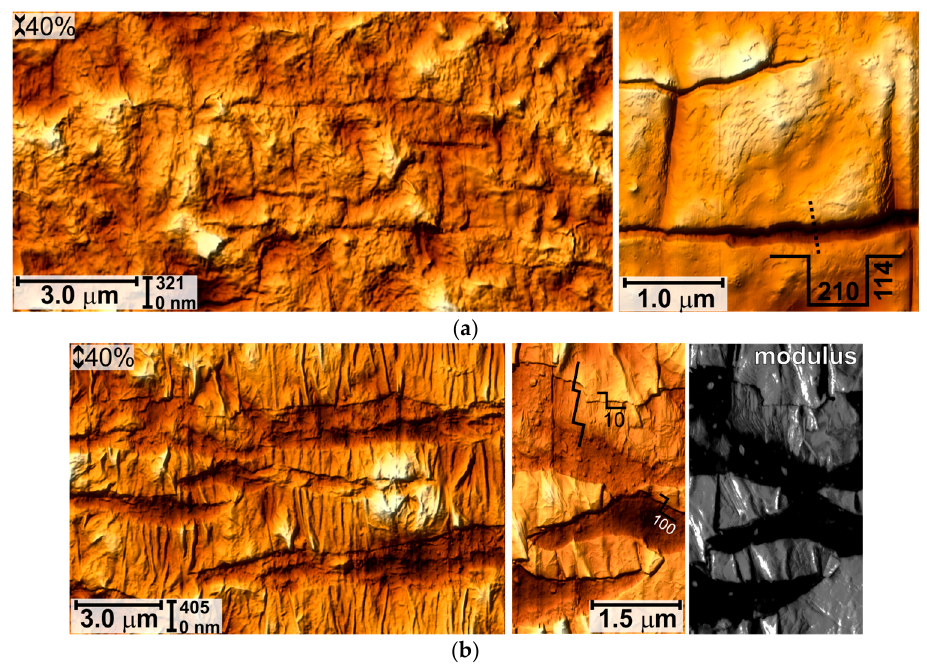
Figure 5. AFM images of PU after the PIII 1-16 and fatigue loading to 40% in the unloaded ( a ) and stretched ( b ) states. The stepped surface in ( b ) indicates the in plane fracture of the modified layer. The height of steps is shown (in nm).